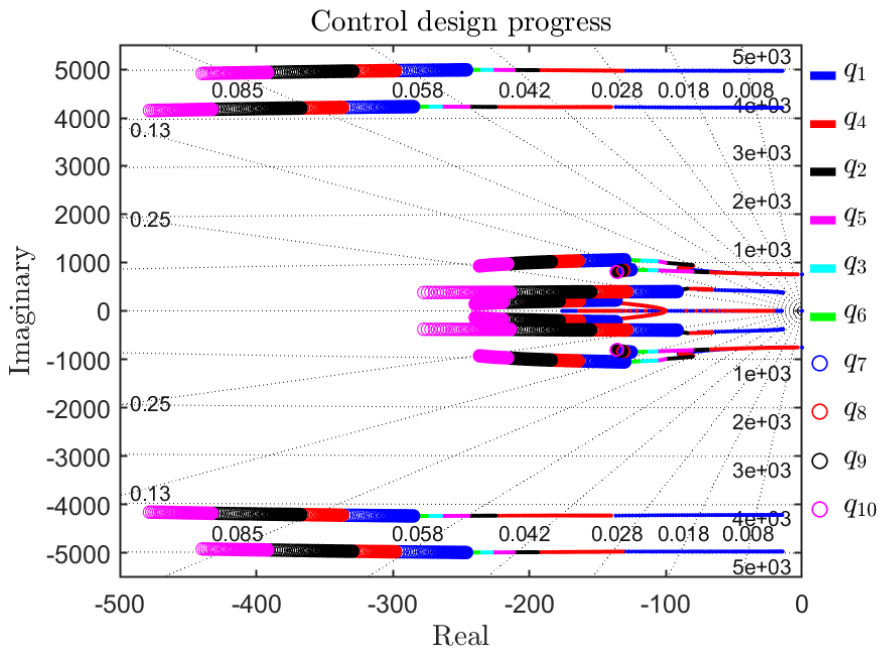
Figure 6. Loci of the closed-loop system poles for the LCL -type filter without additional